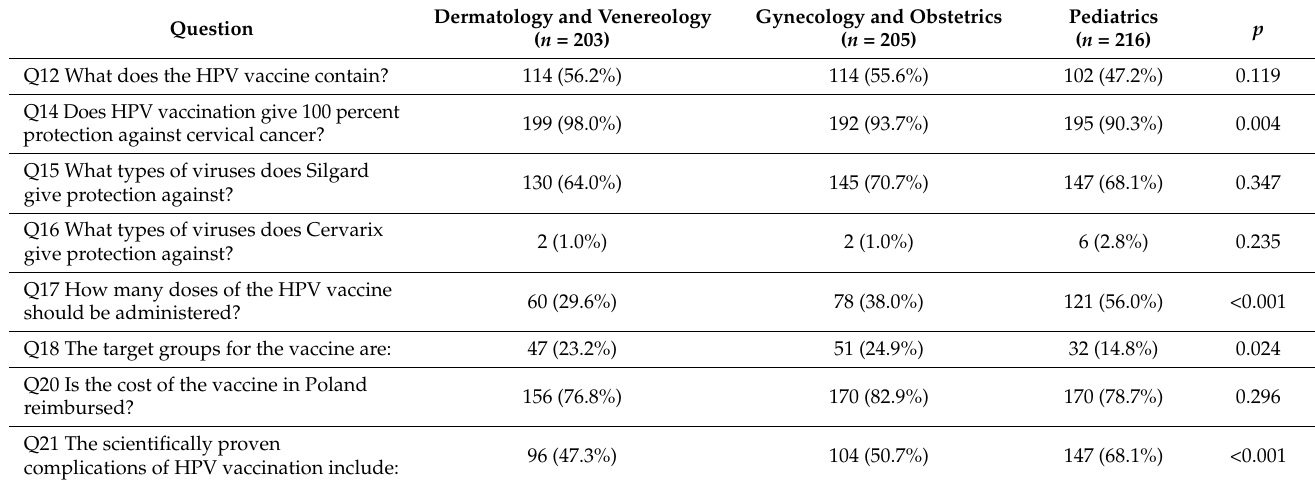
Table 6. Correct answers to the questions about HPV vaccination depending on the